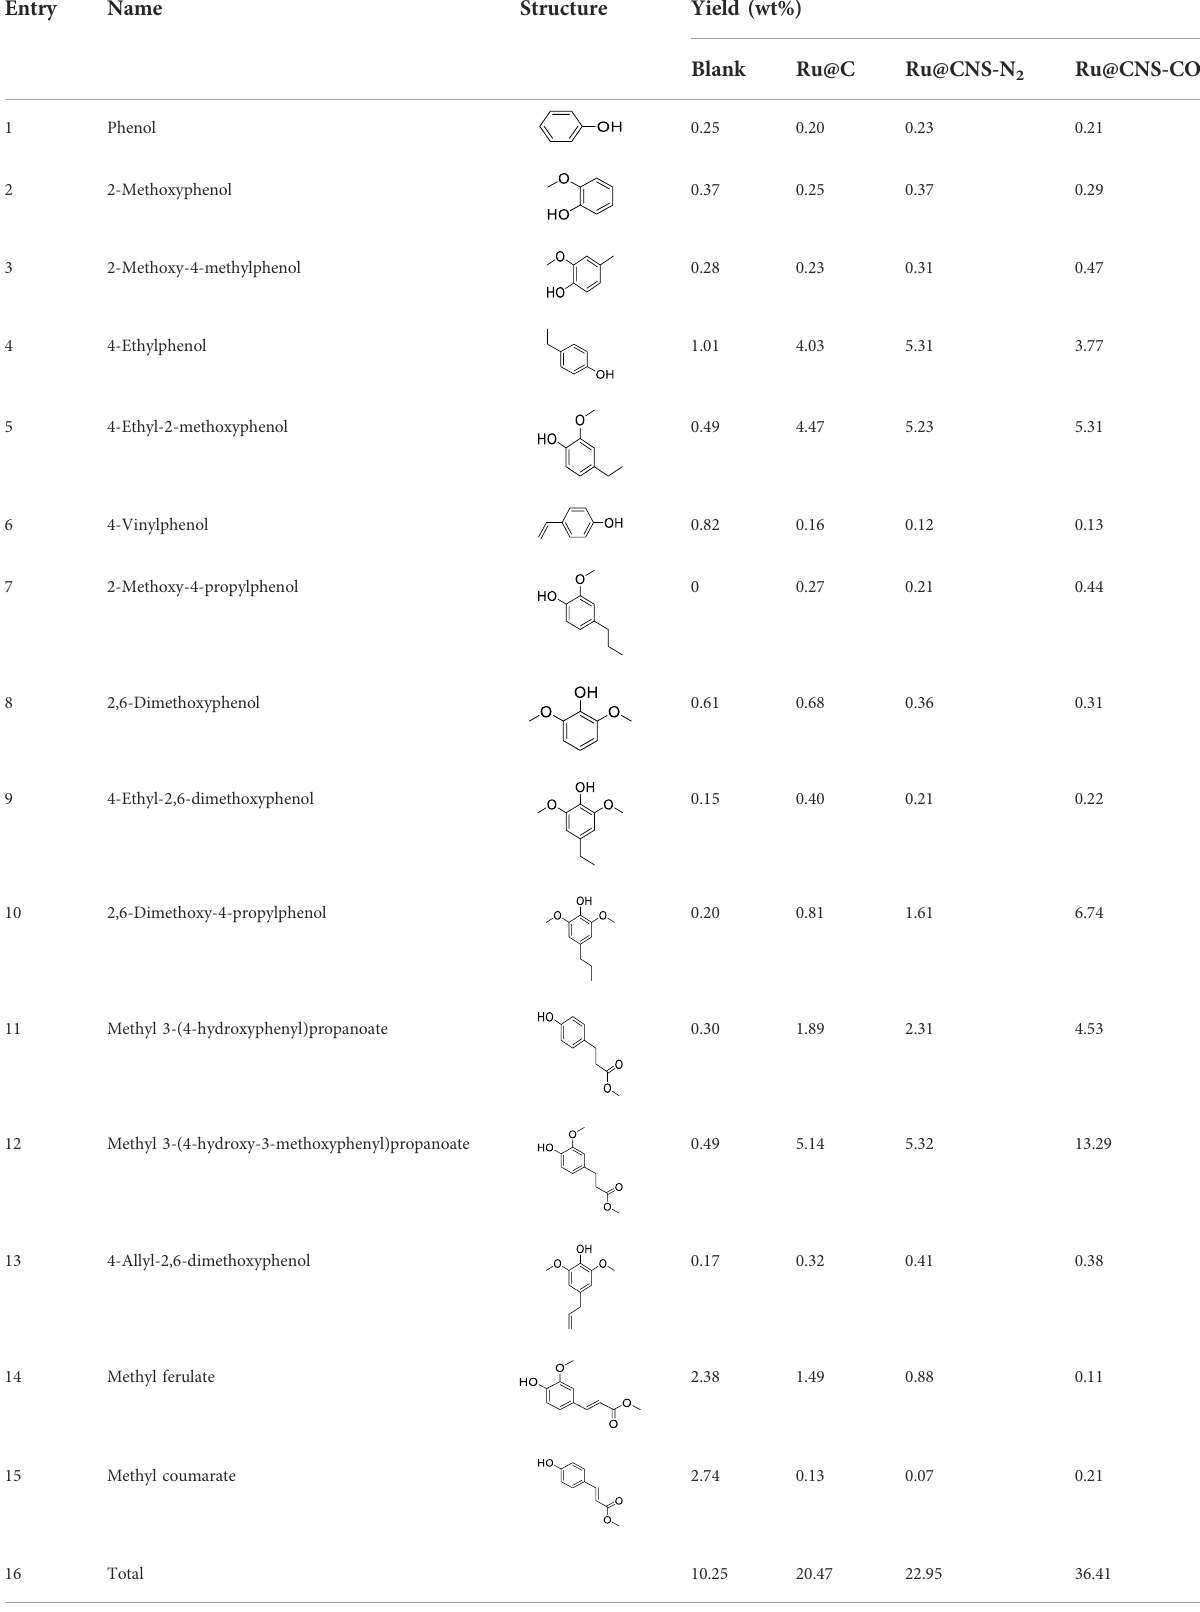
TABLE 2 Yields of phenolic monomers from catalytic depolymerization of lignin over different catalysts. Entry